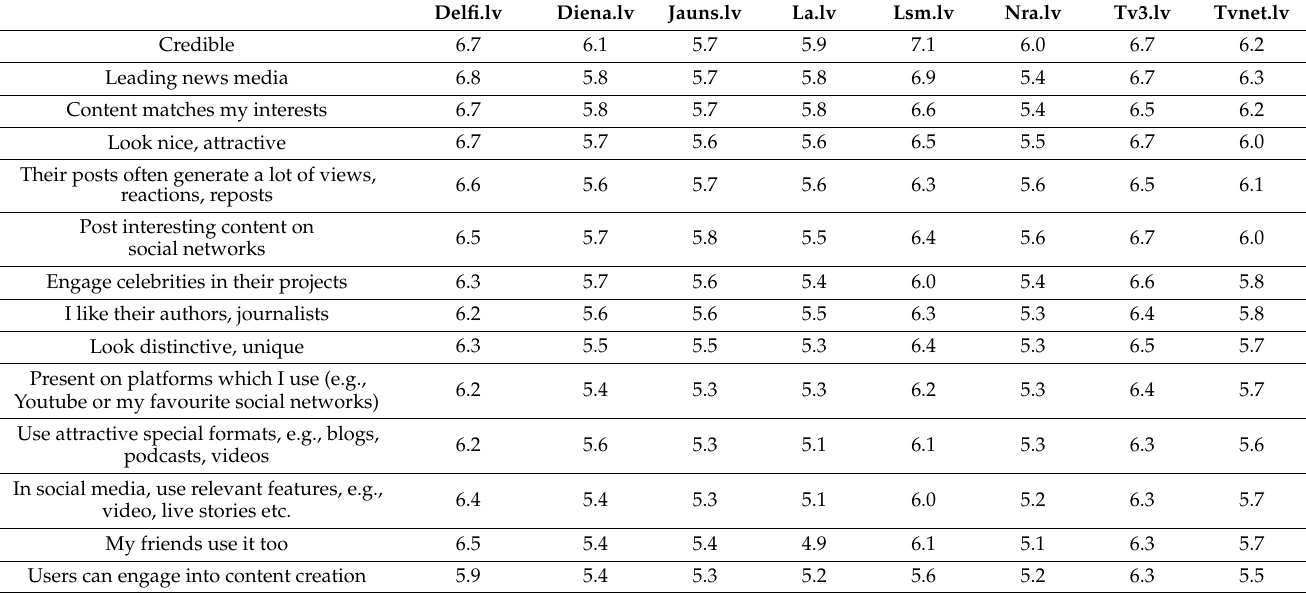
Table 8. News media attribution evaluation by audience 15–24 years old, mean calculations,